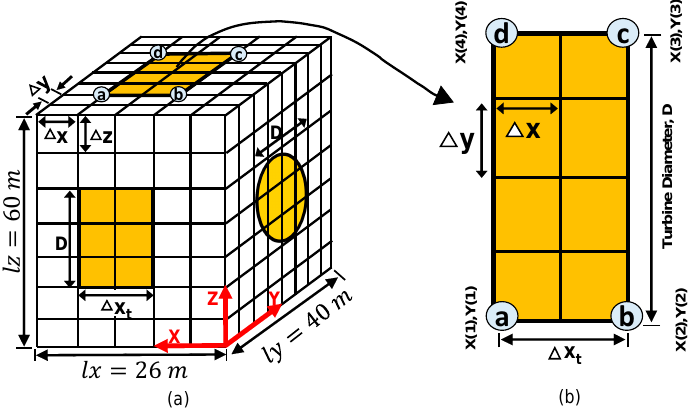
Figure 2. Graphical information of the implementation of the actuator disc approach on the structured grid. Δ𝑥 , Δ𝑦 , and Δ𝑧 are the grids spacing used at the turbine location in x , y , and z directions respectively: ( a ) dimensions of the embedded structured grid in the domain; ( b ) x – y plane displaying the “enclosure” of the disc, where the momentum sink is applied within the specified quadrants (i.e., a, b, c, and d). Note that these figures are not drawn to scale.